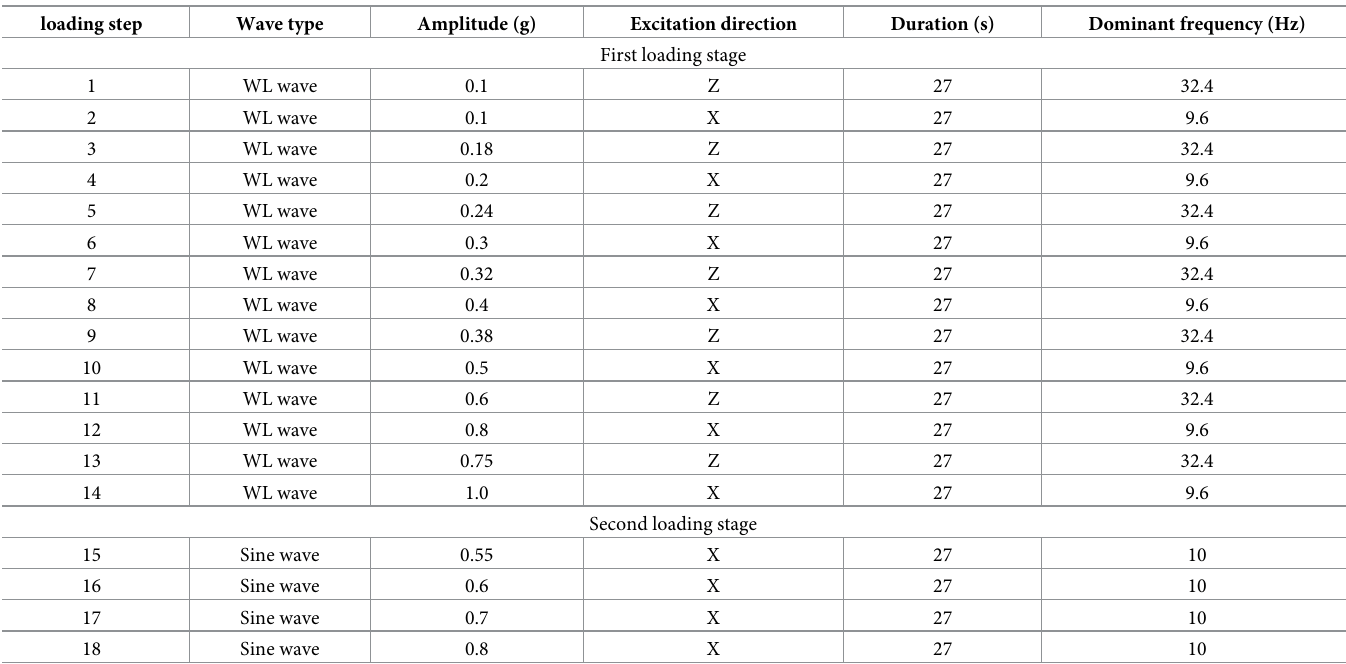
Table 4. Loading scheme of shaking table